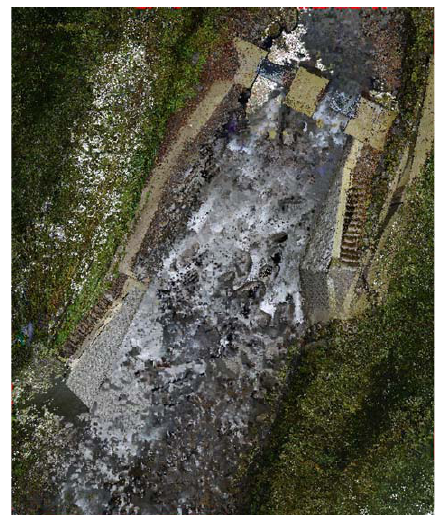
Figure 20. DEM after the PatchMatch